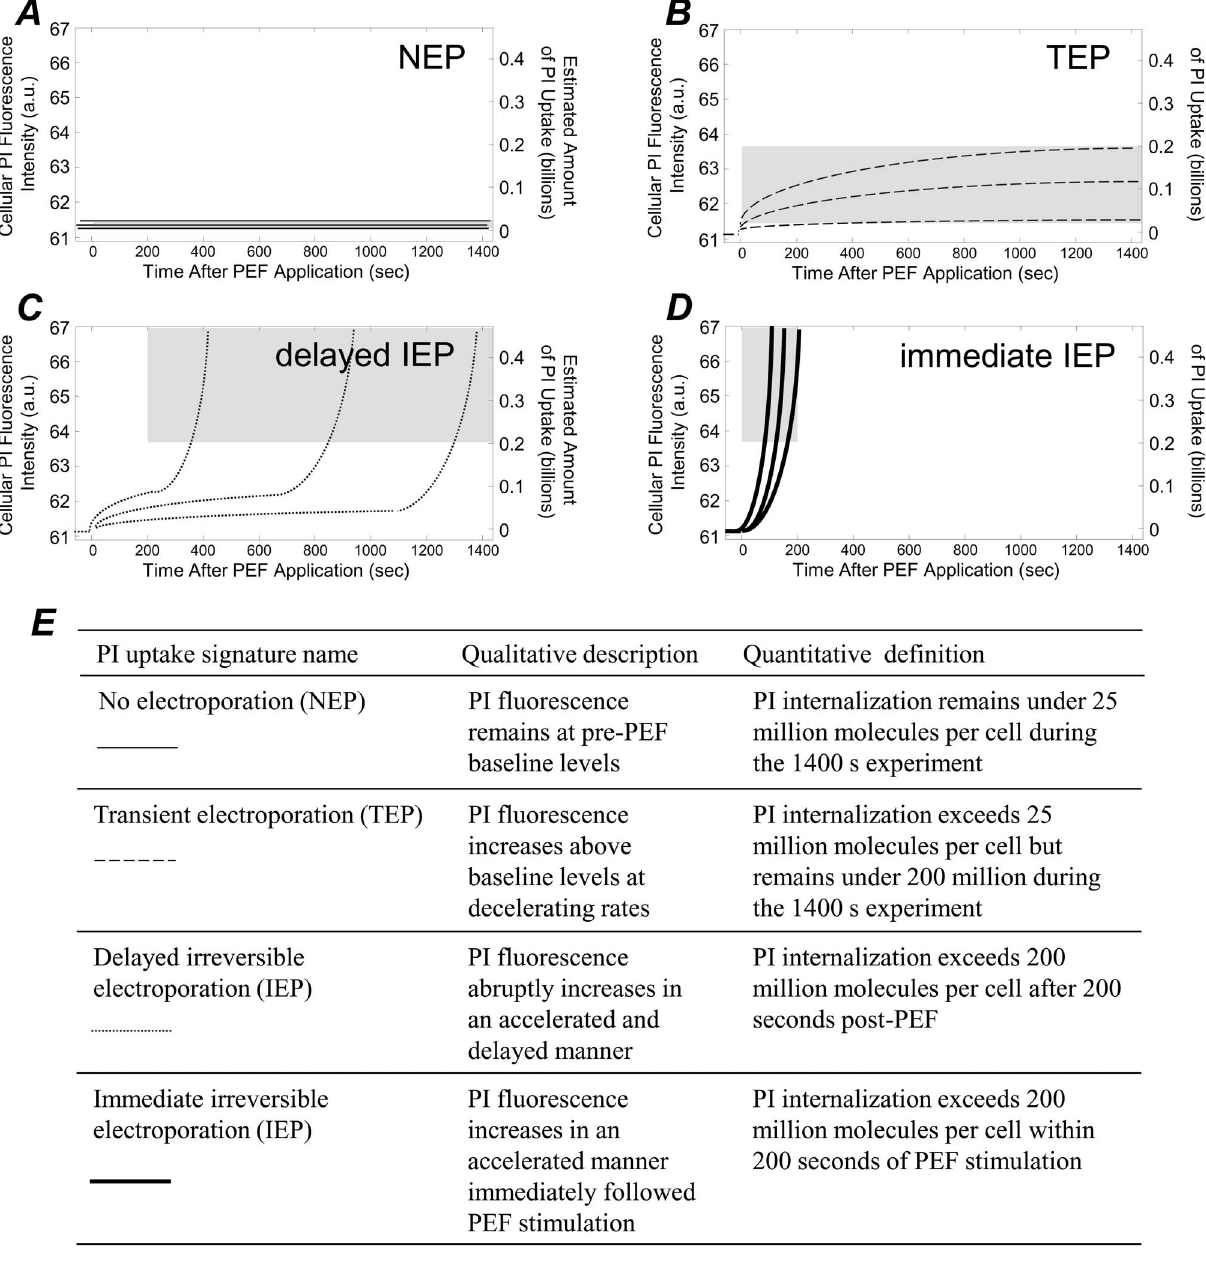
Figure 5. PI uptake versus time signatures from every experiment from each cell fell into one of four categories, as defined here. A : The NEP signature is assigned to cells that remain at baseline PI fluorescence levels of , 25 million molecules per cell during the 1400 second experimental time course. B : The TEP signature is assigned to cells that internalize between 25 and 200 million PI molecules per cell during the 1400 second time course. C : The delayed IEP signature is assigned when cells internalize more than 200 million PI molecules per cell between 200 and 1400 seconds after PEF stimulation. D : The immediate IEP signature is assigned when cells internalize more than 200 million PI molecules within the first 200 seconds after PEF exposure. E : A table summarizing the names, qualities, and quantitative definitions of each signature. In A – D , grey regions on plots are provided to indicate the widows defining the uptake signature in terms of PI uptake amount and timeframes.